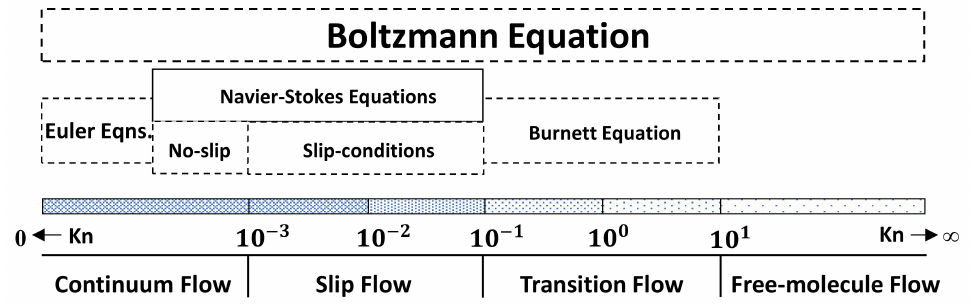
Figure 1. Knudsen number and gas flow